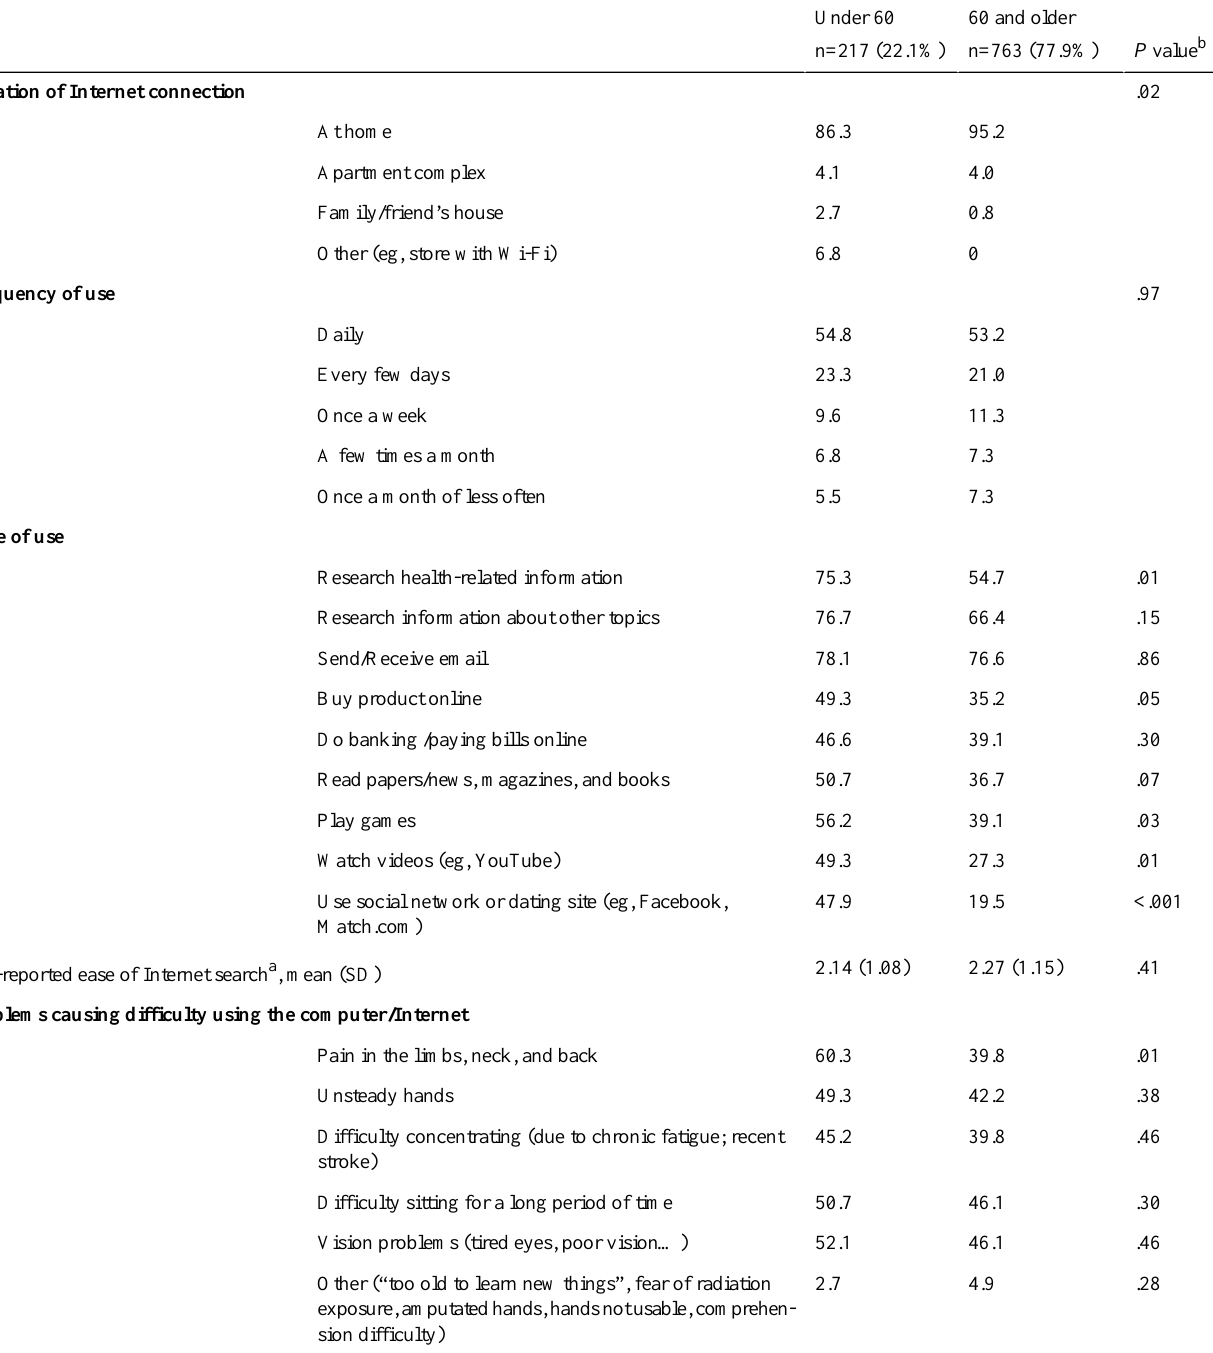
Table 4. Internet use patterns and activities among current